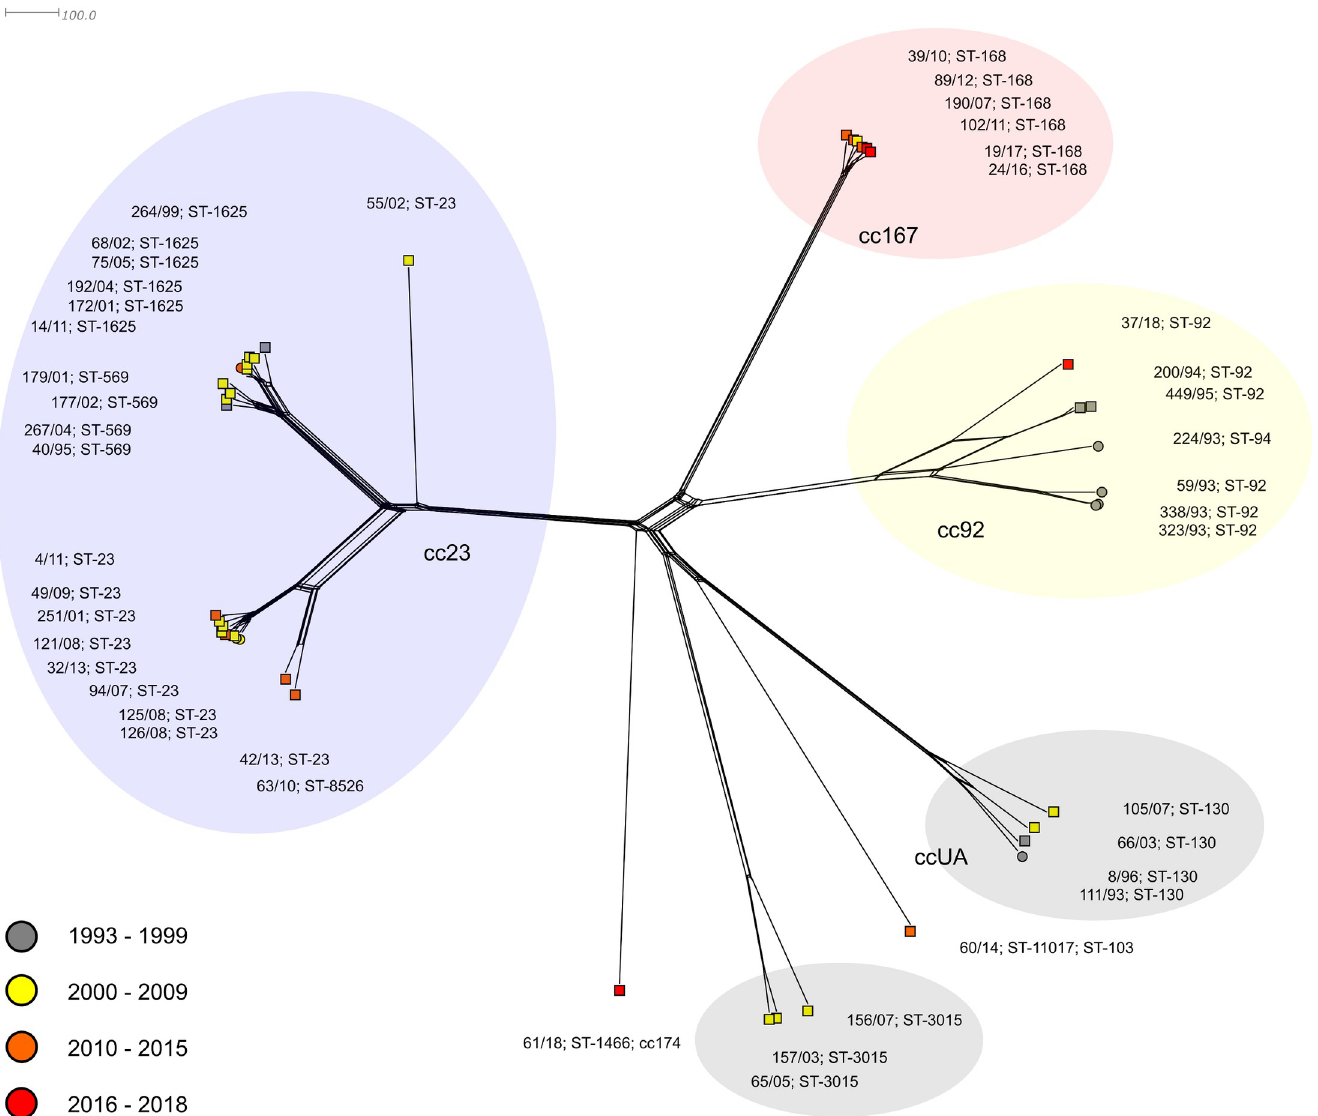
Fig 1. Genetic relationship of N . meningitidis Y isolates collected in the Czech Republic from 1993 to 2018. Neighbour-net network of MenY isolates (n = 43). Isolates are coloured according to detection year and labelled by their NRL number, ST, and cc. Invasive isolates are marked with a square, carriage isolates with a